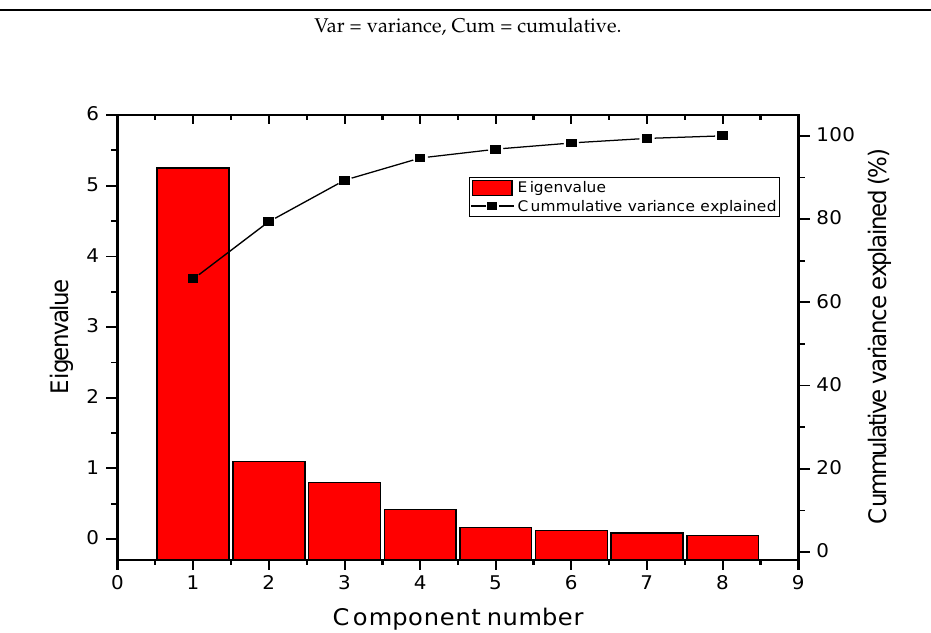
Figure 8. Scree plot for PCA with normalized eigenvalues.